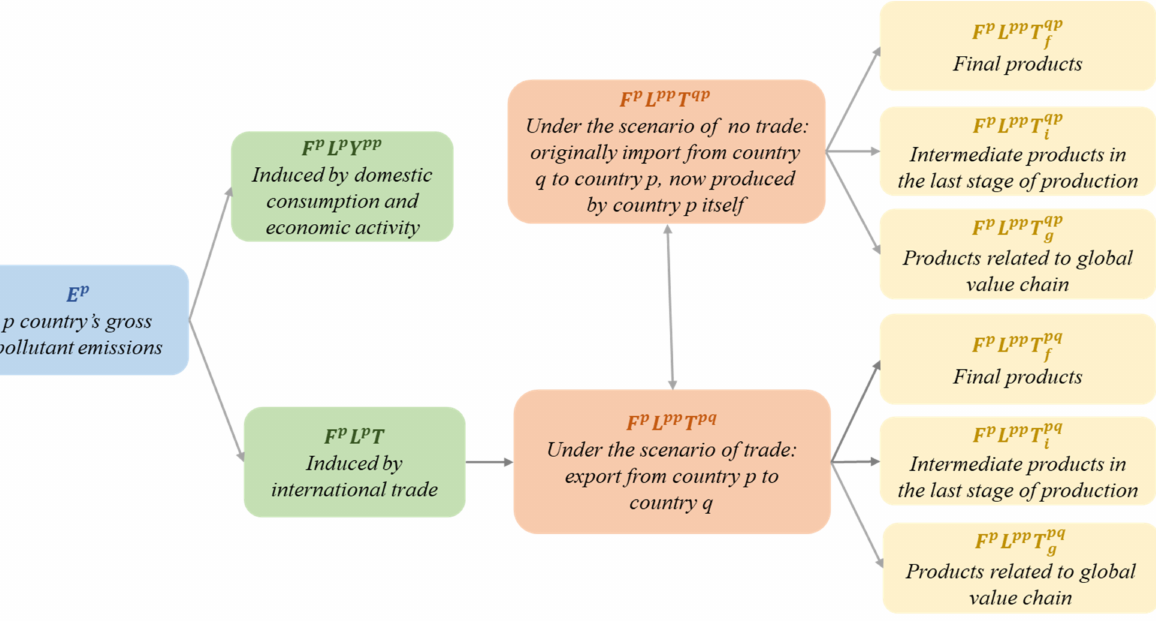
Figure 1. The decomposition of country p’s gross pollutant